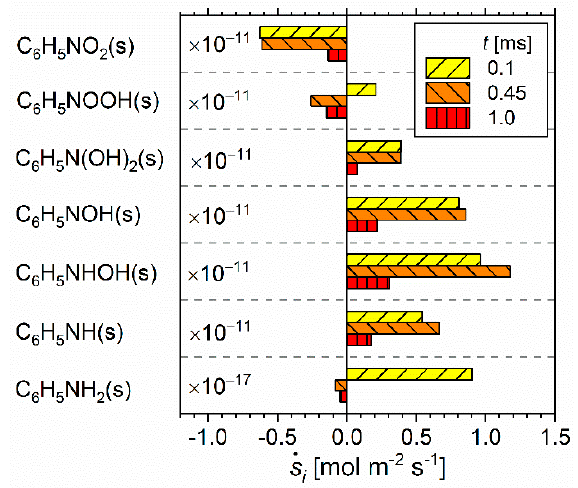
Figure 10. Variation of production/consumption rates of surface species from the initially empty surface site.